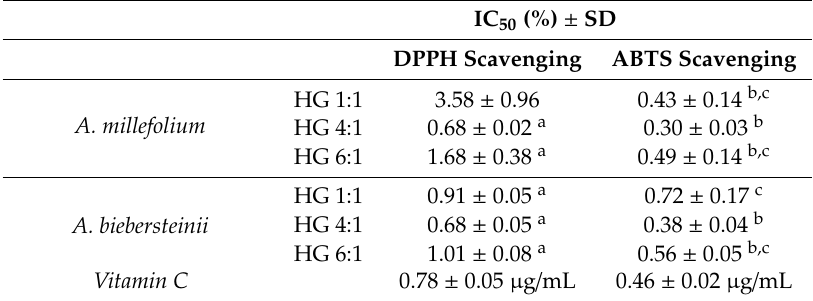
Table 4. DPPH and ABTS radical scavenging activity of hydroglycolic (HG) extracts from A. millefolium and A. biebersteinii; each value represents mean ± SD ( n = 3 ). Means in each column not sharing the same letter are significantly di ff erent at p <